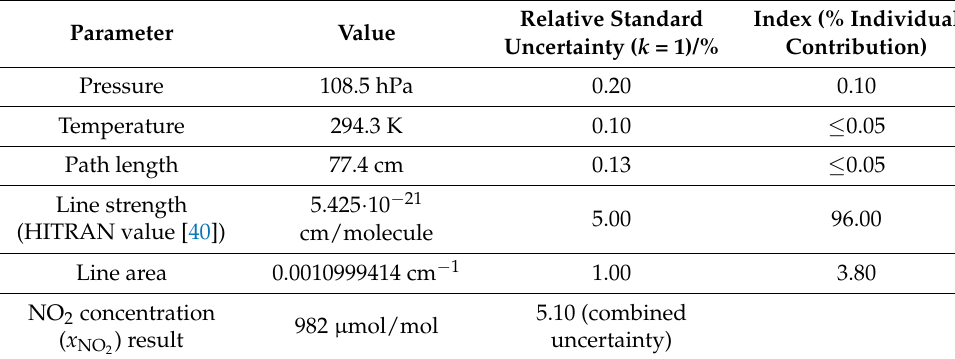
Table 1. Uncertainty budget of the NO 2 amount fraction results.